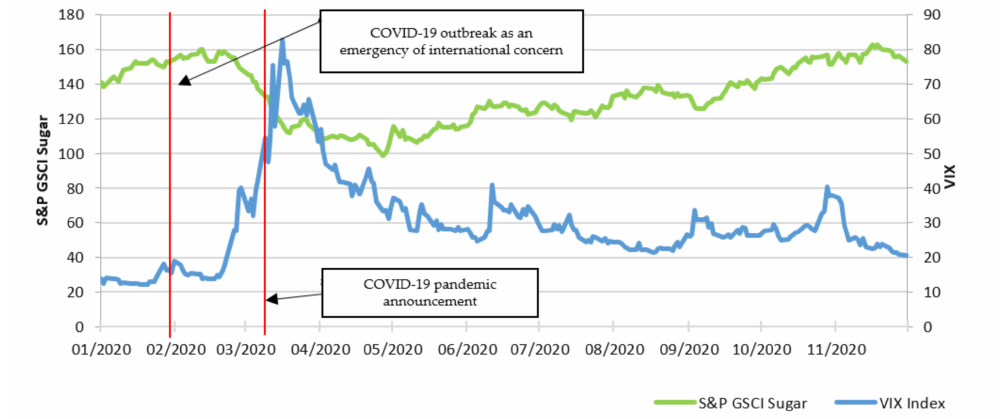
Figure 2. The S&P GSCI Sugar Index and the VIX Index between 2 January 2020—8 October 2020. Source: authors’ own elaboration based on Refinitiv Datastream data.